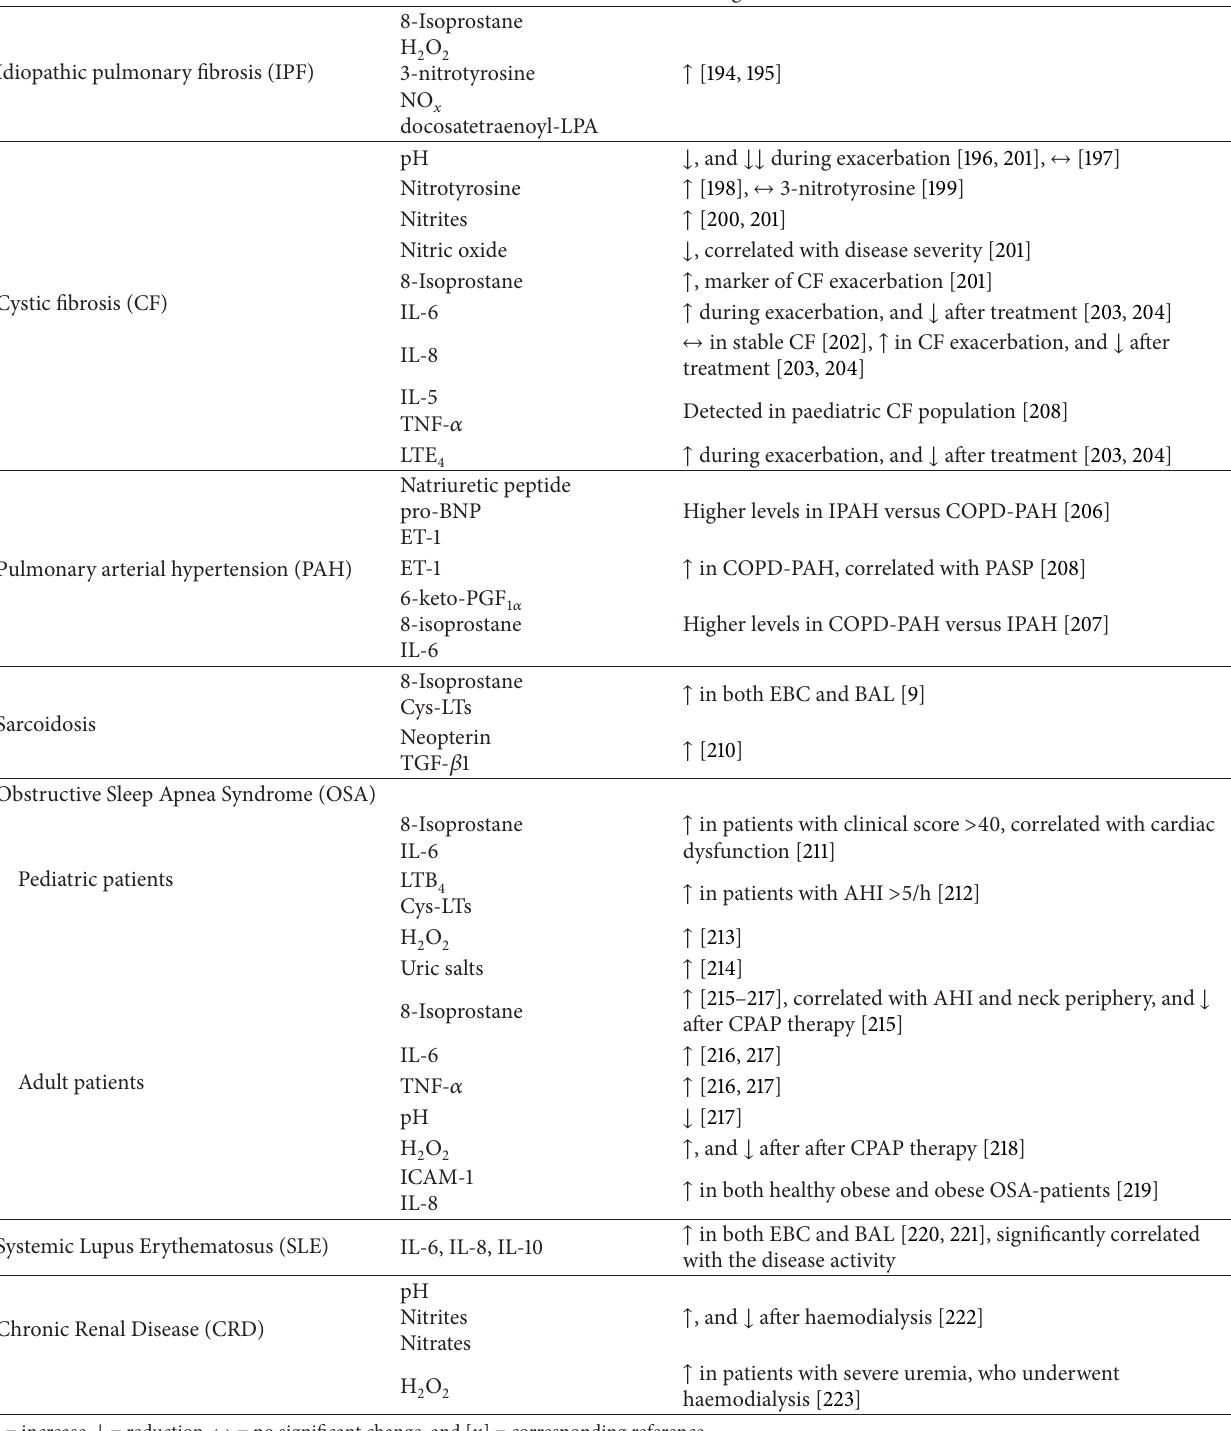
Table 5: Exhaled breath condensate biomarkers in several lung and systemic